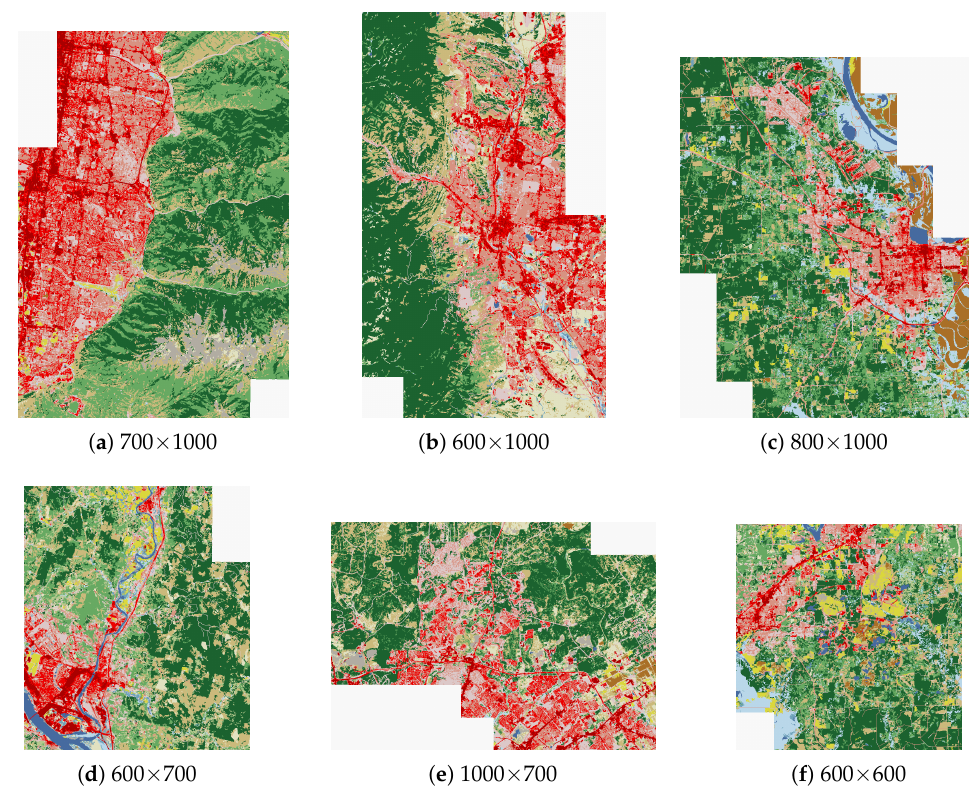
Figure 17. Top six retrieval results of reference III acquired by the use of the proposed